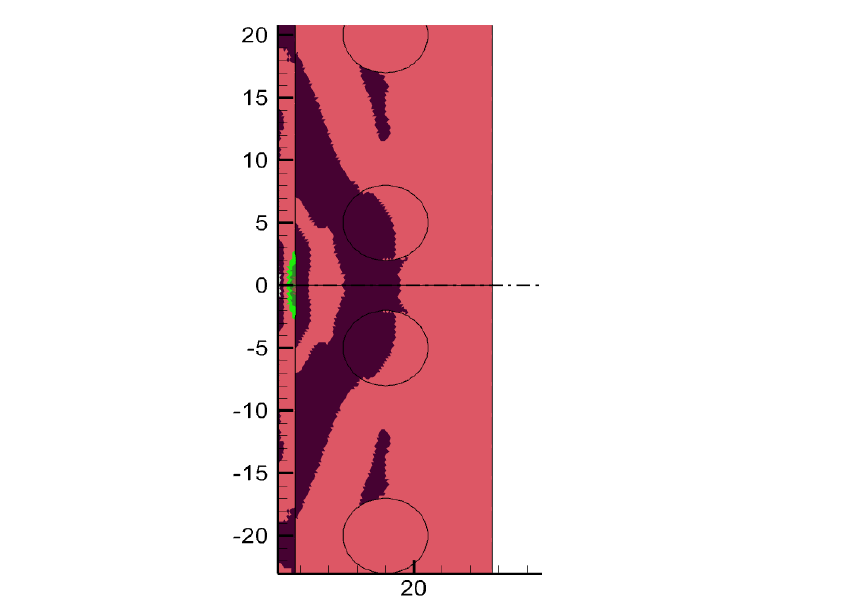
Fig. 6. Compression wave in the gelatin layer, 10 µs.